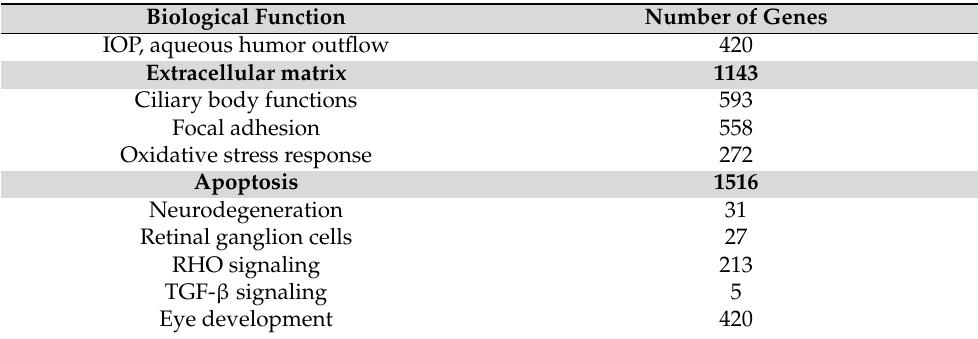
Table 6. Target genes of the eight miRNAs showing significantly different expression profile be- tween